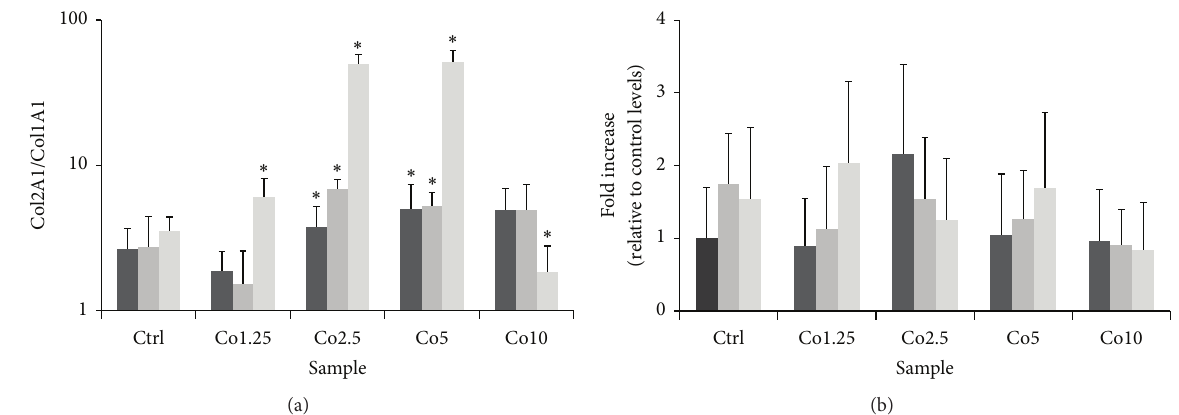
Figure 6: (a) Col1A1/Col1A2 mRNA ratio synthetized by hADSCs encapsulated within Ca/Co alginate beads. (b) qRT-PCR analysis of Col10A1. Expression levels of marker genes were normalized to that of GAPDH and calculated as fold changes relative to expression levels of hADSCs encapsulated within control Ca alginate beads at 7 days. Black bar: 7 days; dark grey bar: 14 days; light grey bar: 21 days. Data are given as means ± the SD ( 𝑛 = 3 independent experiments; ∗ 𝑃 < 0.05